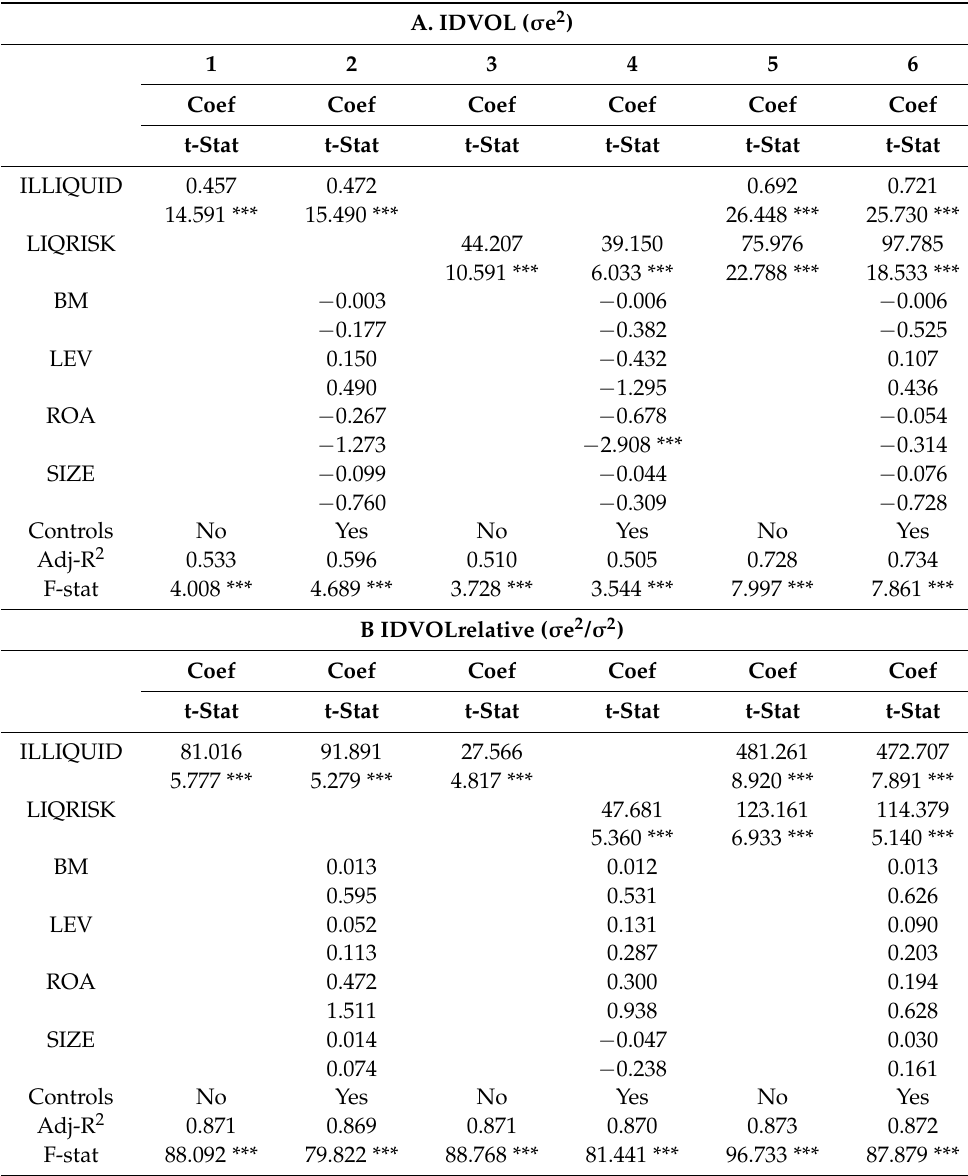
Table 6. Information environment and idiosyncratic